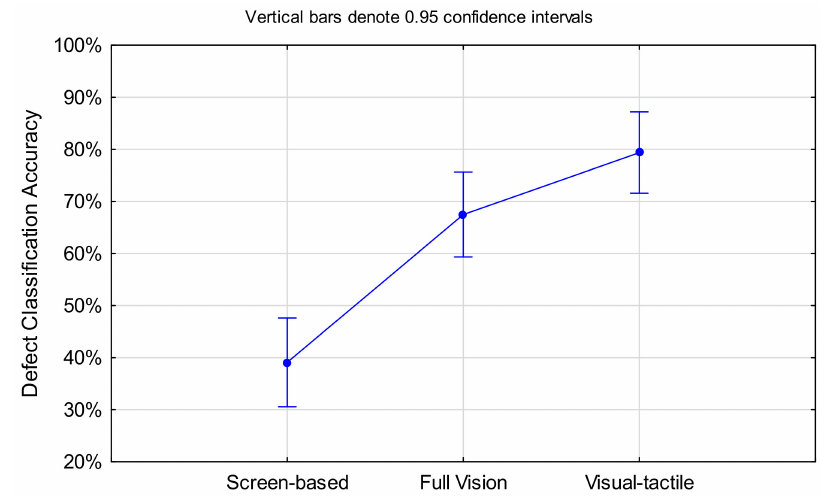
Figure 6. Mean plot of defect classification accuracy by inspection